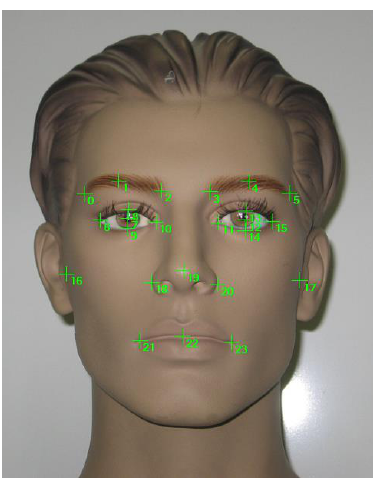
Figure 5. Facial features.